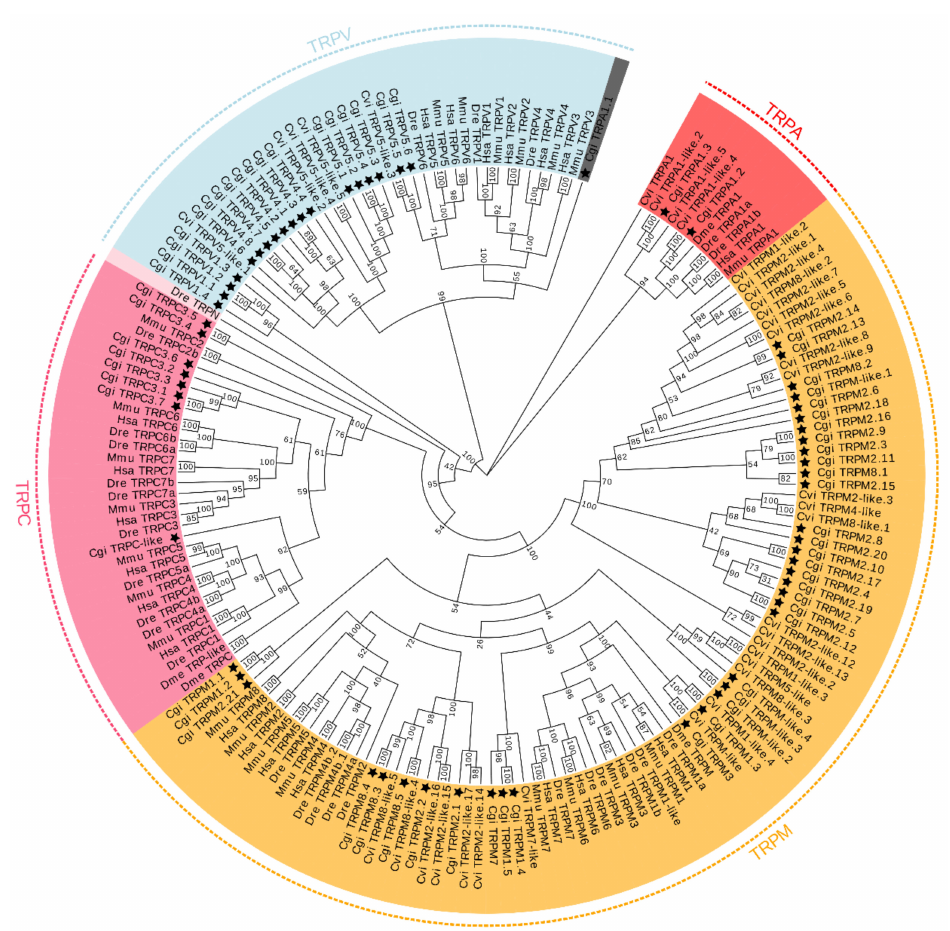
Figure 2. Phylogenetic analysis of TRP genes in C. gigas . The maximum-likelihood tree was inferred using the edge-linked partition model in IQ-TREE program. Numbers around the nodes correspond to bootstrap support values in percentages. Accession numbers for all sequences are provided in Table S1. Abbreviations: Hsa, Homo sapiens ; Mmu, Mus musculus ; Dre, Danio rerio ; Dme, Drosophila melanogaster , Cvi, Crassostrea virginica and Cgi, Crassostrea gigas . The C. gigas TRPs are indicated by